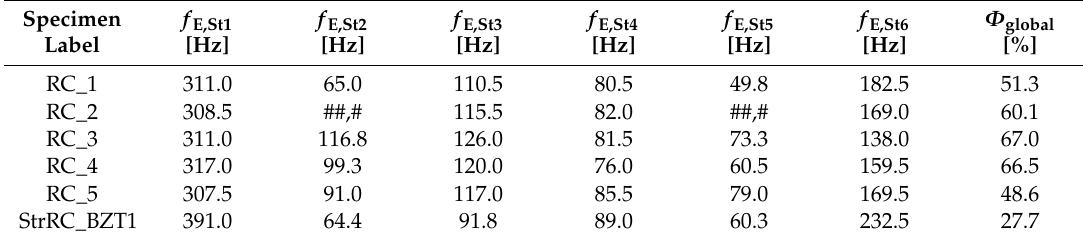
Table 5. Measured eigenfrequencies for each stimulation f E,Stx and global damage Φ global ; Hering [17]. Specimen